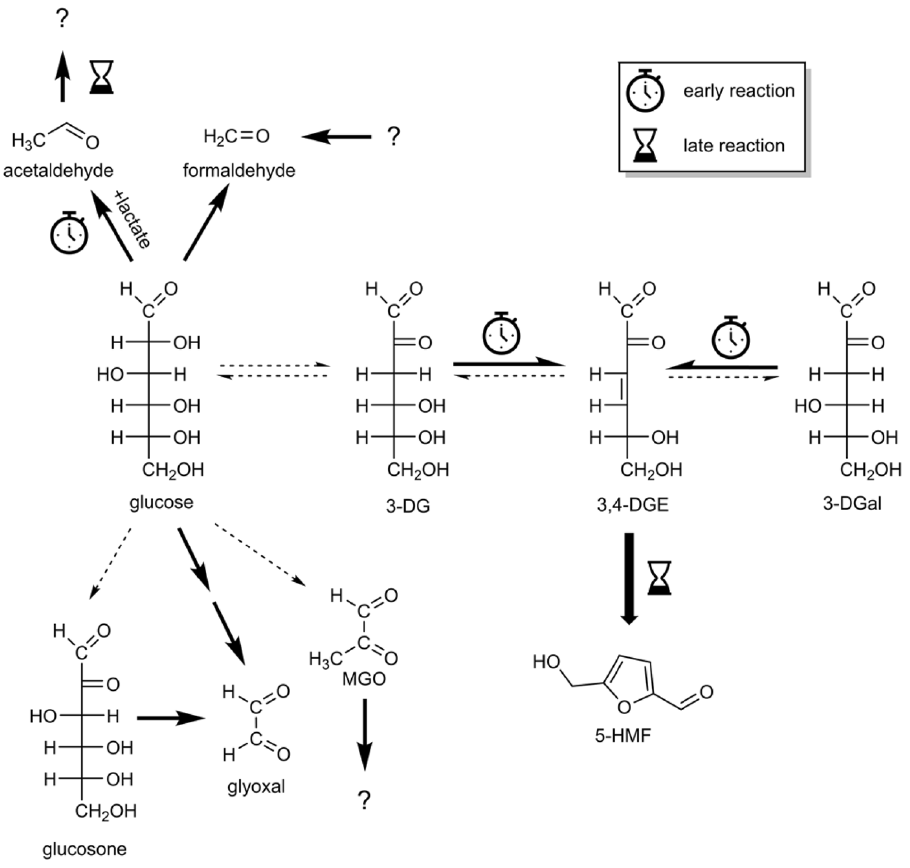
Figure 5. Mechanistic interpretation of changes of the GDP profile in single-chamber PDFs during storage. Reactions leading to changes in the GDP profile are marked with bold arrows; reactions marked with dashed arrows are either not favored during storage or are overcompensated by other reactions and, therefore, do not lead to changes of the GDP profile. Early reactions predominate during short-term storage, whereas late reactions predominate during longer storage